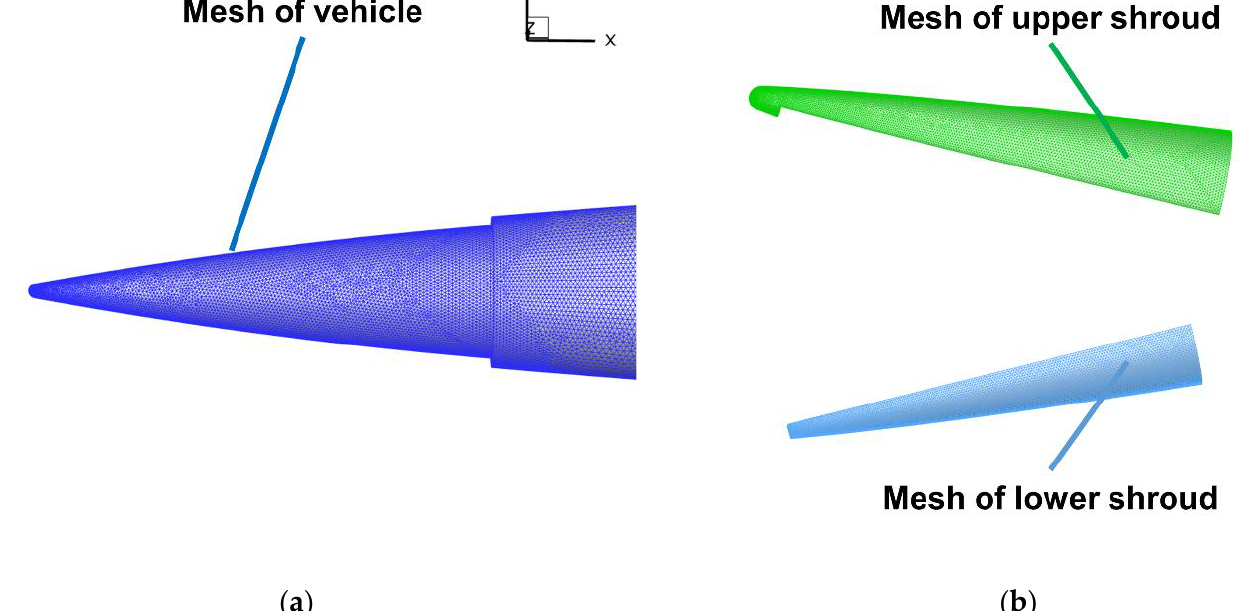
Figure 6. The surface mesh of the vehicle and shrouds: ( a ) surface mesh of the vehicle; ( b ) surface mesh of the shrouds.